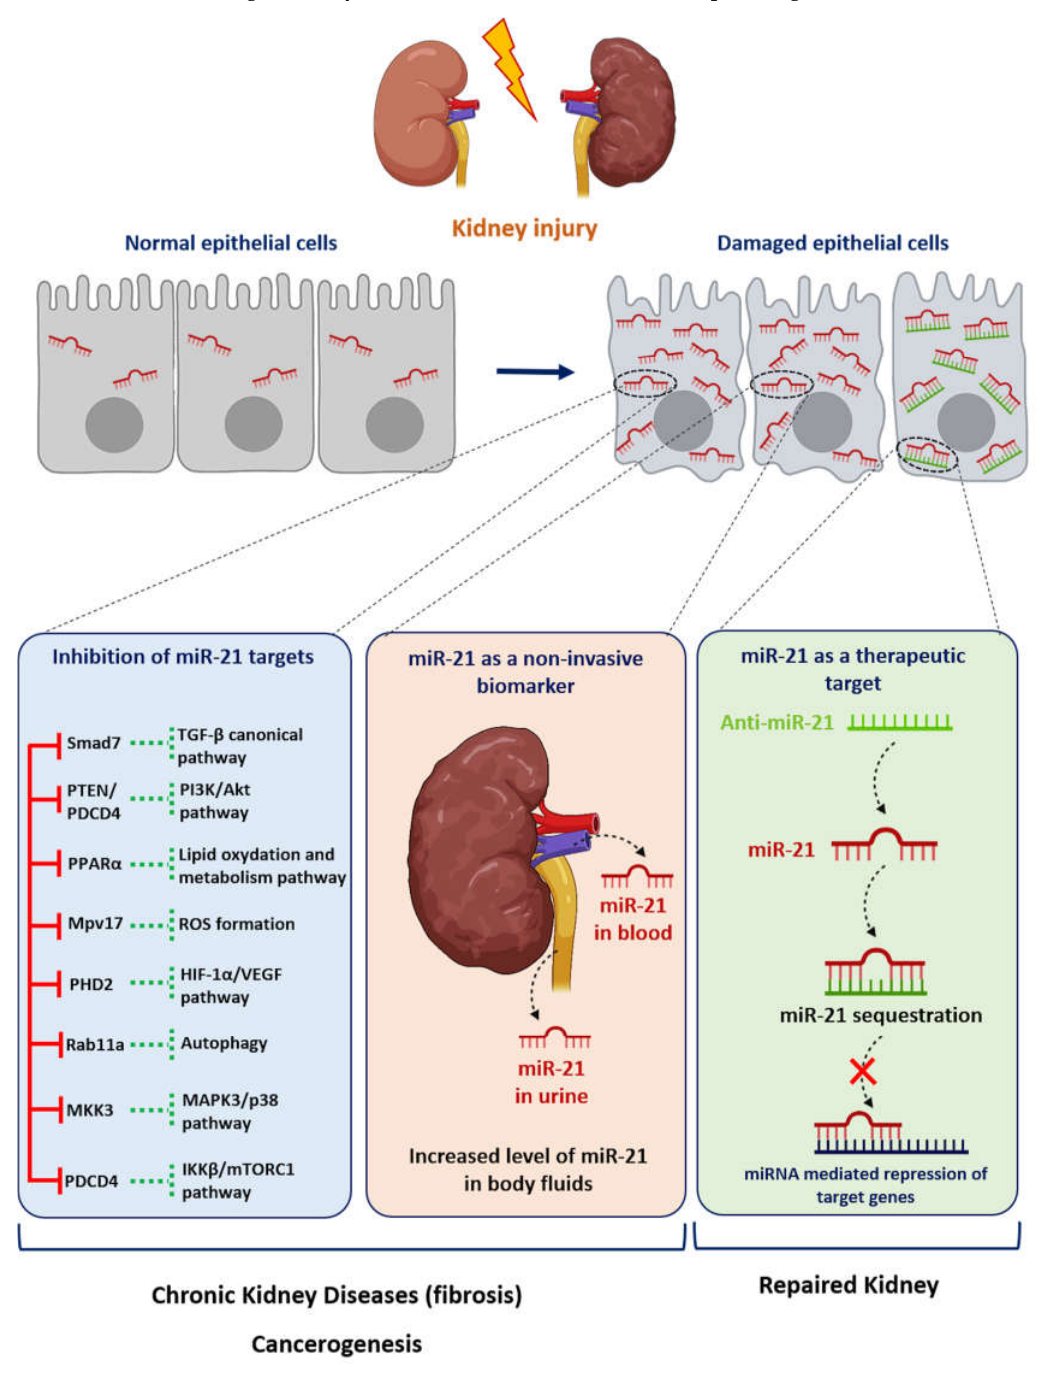
Figure 3. Role of miR-21 in kidney diseases. Following injury, the expression of miR-21 is increased in renal cells. miR-21 promotes kidney diseases by repressing various target genes. Levels of miR-21 can be assessed in urine or blood samples as a biomarker of kidney injury. Given its established pathogenic role in kidney disorders, targeting miR-21 using antisense oligonucleotides may represent a new therapeutic strategy for renal diseases.